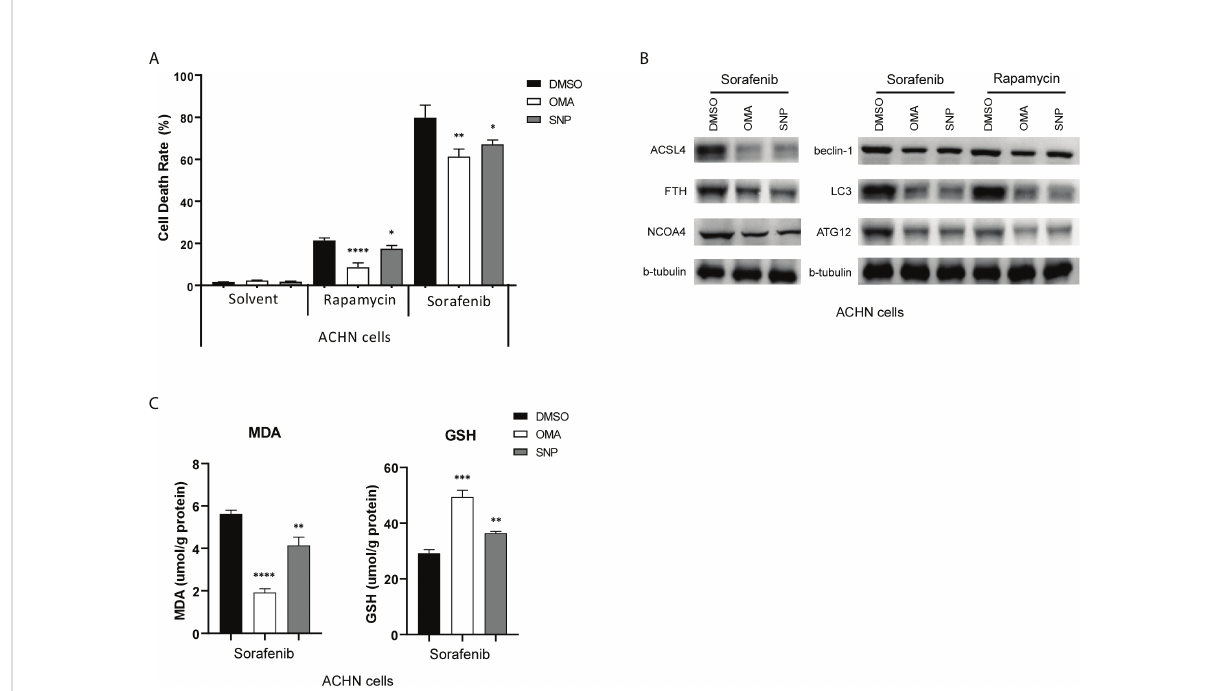
FIGURE 11 ACO1 or IREB2 inhibitor pretreatment reduces sorafenib-induced and rapamycin-induced cell death in renal cancer cells. (A, B) ACHN cells were pretreated with OMA (5 mM) for 24 h or with SNP (100 µM) for 6 h, followed by sorafenib (10 µM) or rapamycin (10 nM) treatment for 24 h. Cells were harvested for the Cell Counting Kit-8 assay (A) or Western blot assays with the antibodies as indicated (B) . b-tubulin blots served as the protein loading control. The asterisk indicates a signi fi cant difference compared to the DMSO control (P < 0.05, Student ’ s t-test). (C) Concentrations of MDA (left) and GSH (right) were detected with indicated treatments. OMA, sodium oxalomalate; SNP, sodium nitroprusside; DMSO, dimethylsulfoxide; MDA, malondialdehyde; GSH, glutathione. *P < 0.05; **P < 0.01; ***P < 0.001 ****P <